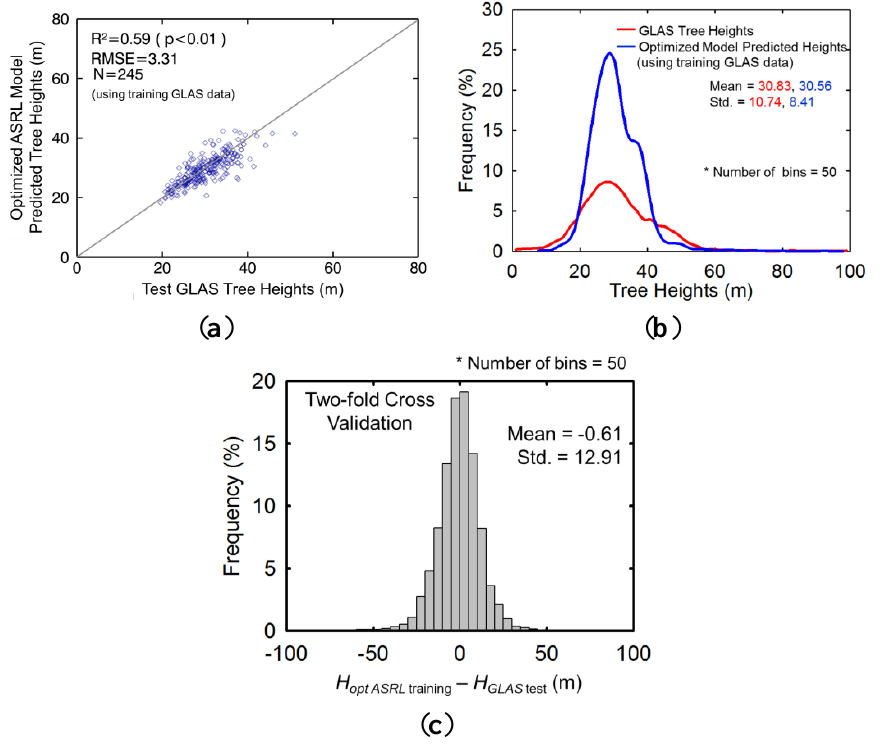
Figure 6. A two-fold cross validation approach showing comparisons between test GLAS tree heights and the optimized ASRL model predictions using training GLAS tree